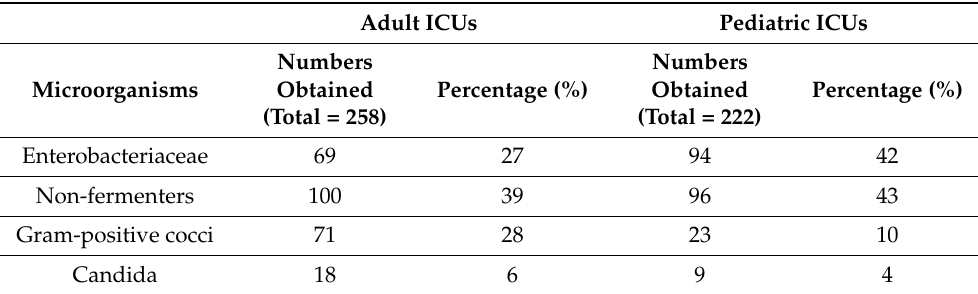
Table 1. The percentage (%) of different groups of microorganisms obtained from adult and pediatric ICUs. Adult ICUs